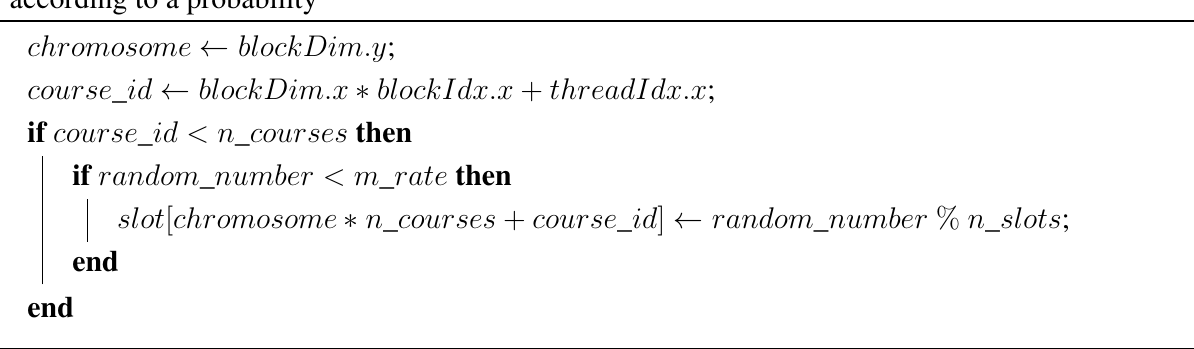
Algorithm 9: Mutation, examination-threaded approach: each thread mutates a single gene, according to a